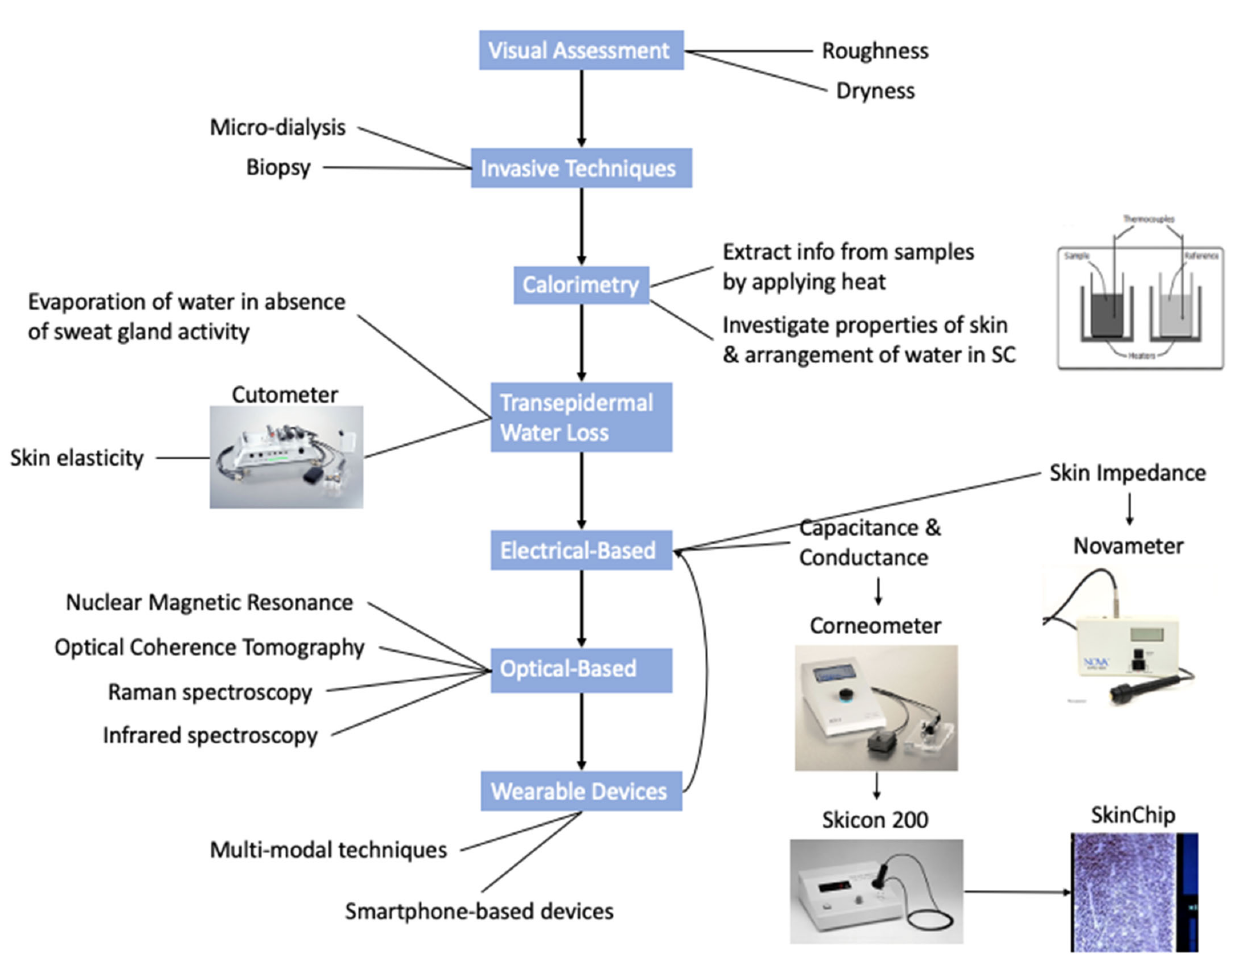
Figure 1. Timeline detailing evolution of skin hydration measurement techniques.